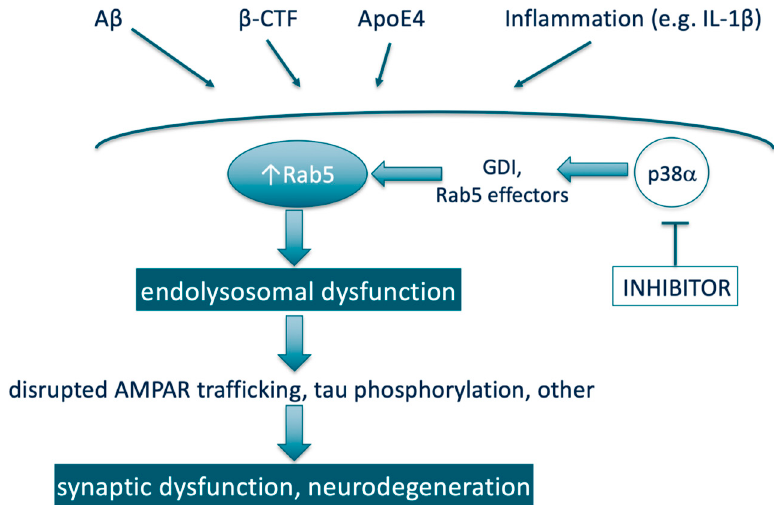
Figure 1. Simplified scheme representing Rab5 as a therapeutic target through being a convergence point for multiple pathogenic drivers of neurodegeneration in AD and the potential of p38 α inhibition as a therapeutic lever to reduce Rab5 activity. Note: A β and β -CTF are both derived from proteolytic processing of APP.